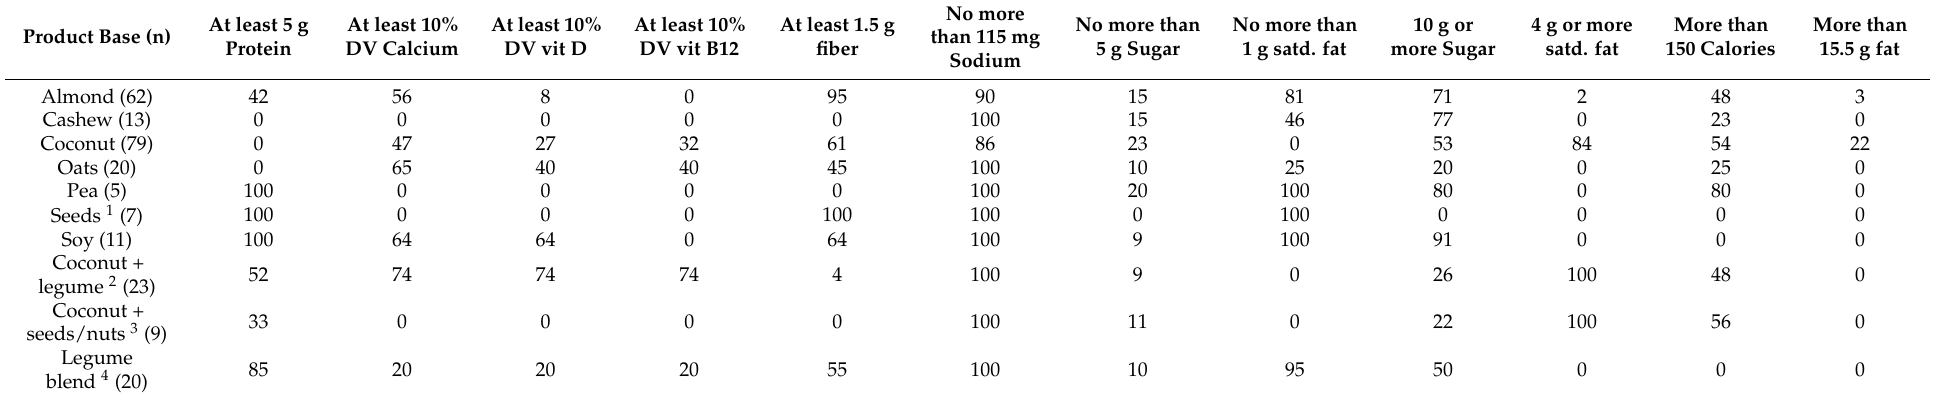
Table 3. The percentage of non-dairy yogurt alternatives meeting or exceeding a suggested guideline [as in Table 2] separated according to the yogurt base. Product Base (n) Almond (62)